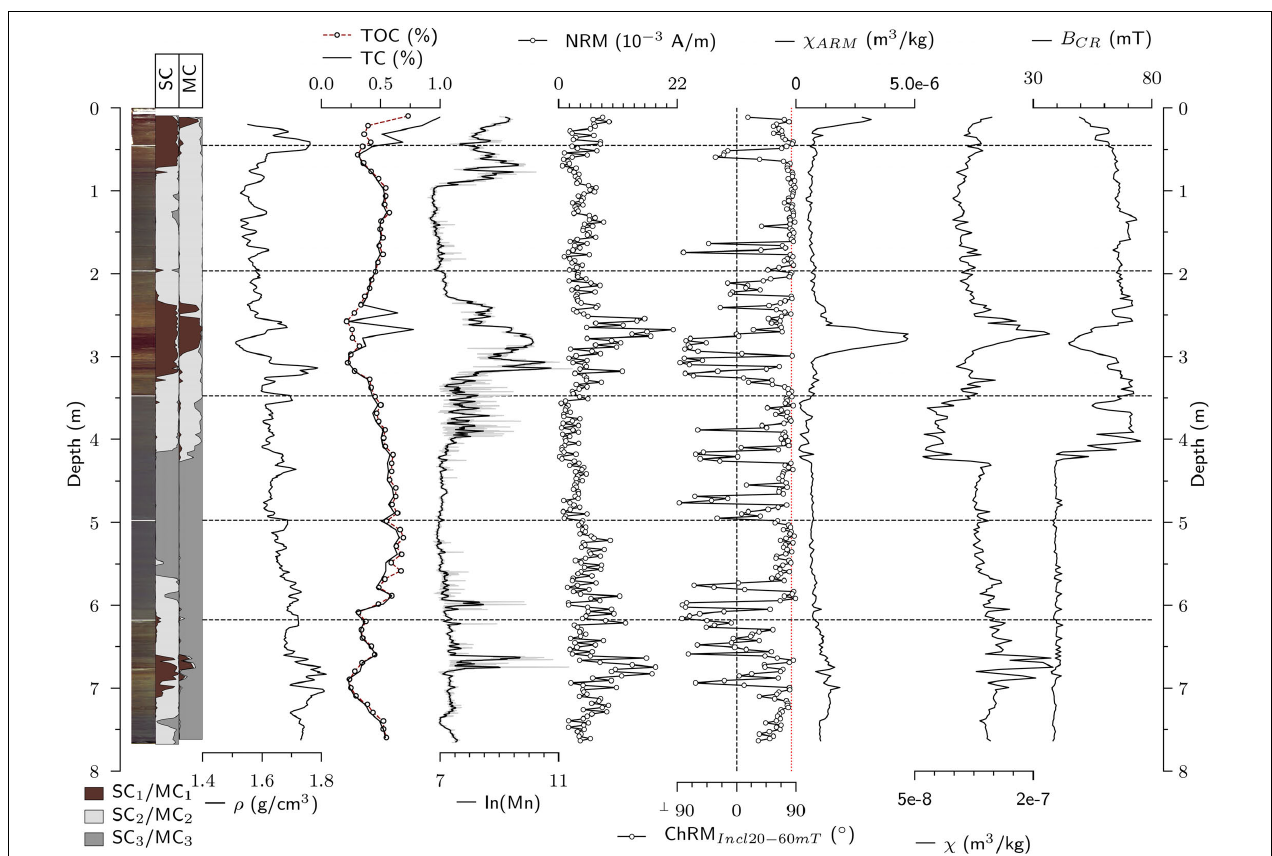
FIGURE 10 | Summary figure that displays the most important parameters of 13PC for comparison. From left to right: line-scan images, fuzzy c-means cluster (FCM) results from physical (SC) and magnetic (MC) properties, density ( ρ ), total carbon (TC) and total organic carbon (TOC), relative manganese (Mn) content, natural remanent magnetisation (NRM) intensity, inclination of characteristic remanent magnetisation based on principal component analysis between 20 and 60 mT, mass normalised susceptibility of anhysteretic remanent magnetisation ( χ ARM ), mass normalised magnetic susceptibility ( χ ) and coercivity of remanence (B CR ).